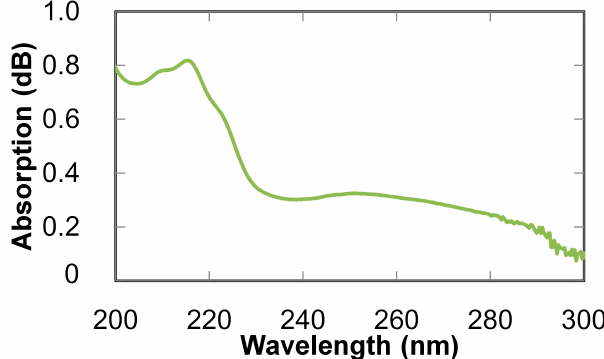
Figure 7. Absorption spectrum of human breath measured with 3-m-long fiber and LDLS.